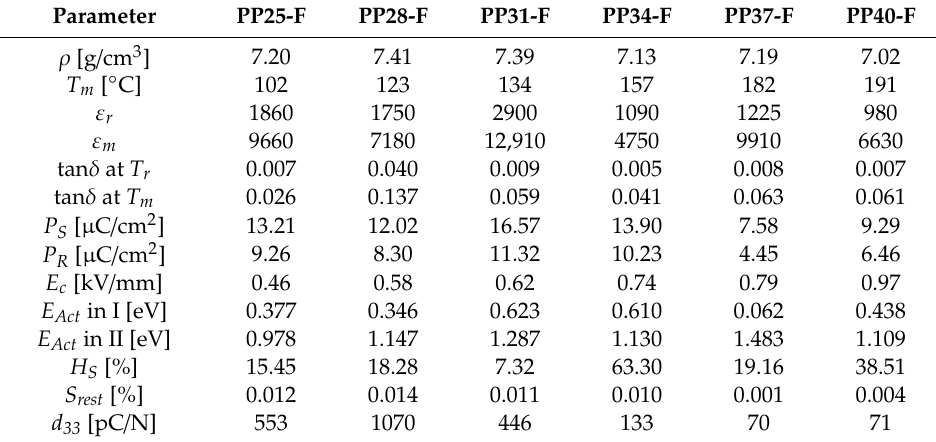
Table 2. Electrophysical parameters of PP–F composite materials.